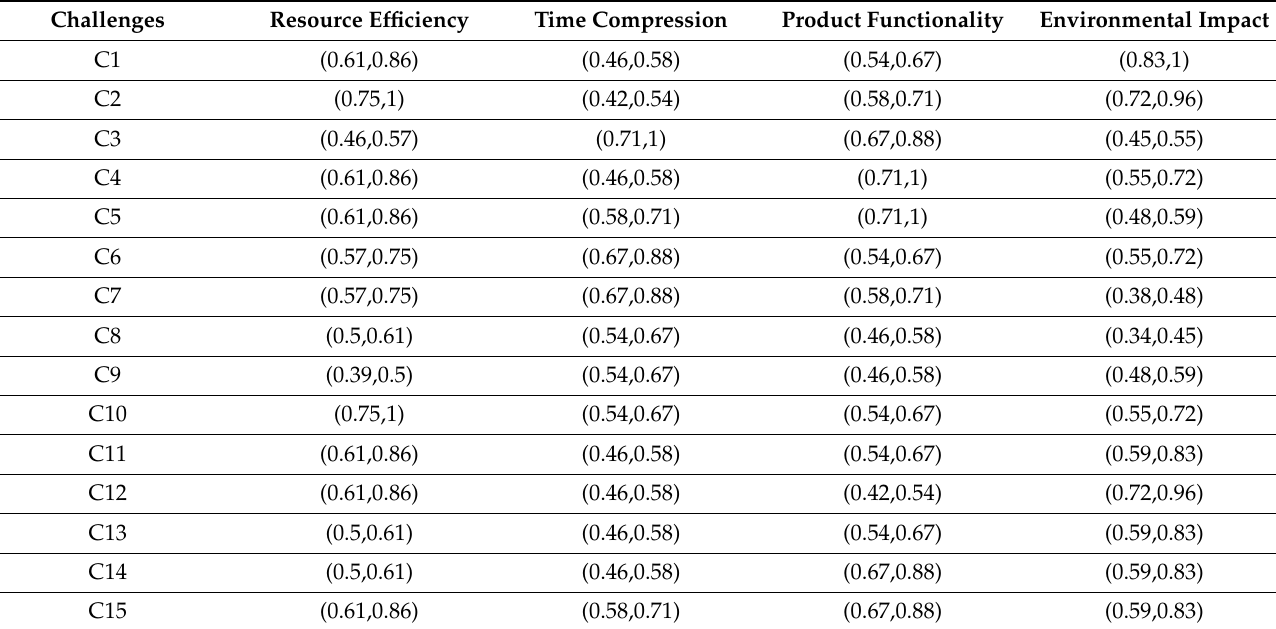
Table 6. Normalized ratings of the challenges.